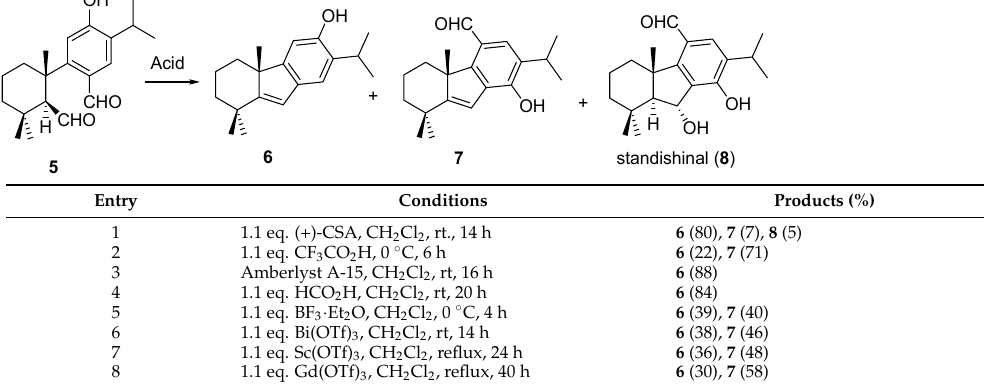
Table 1. Treatment of dialdehyde 5 under different acidic conditions.